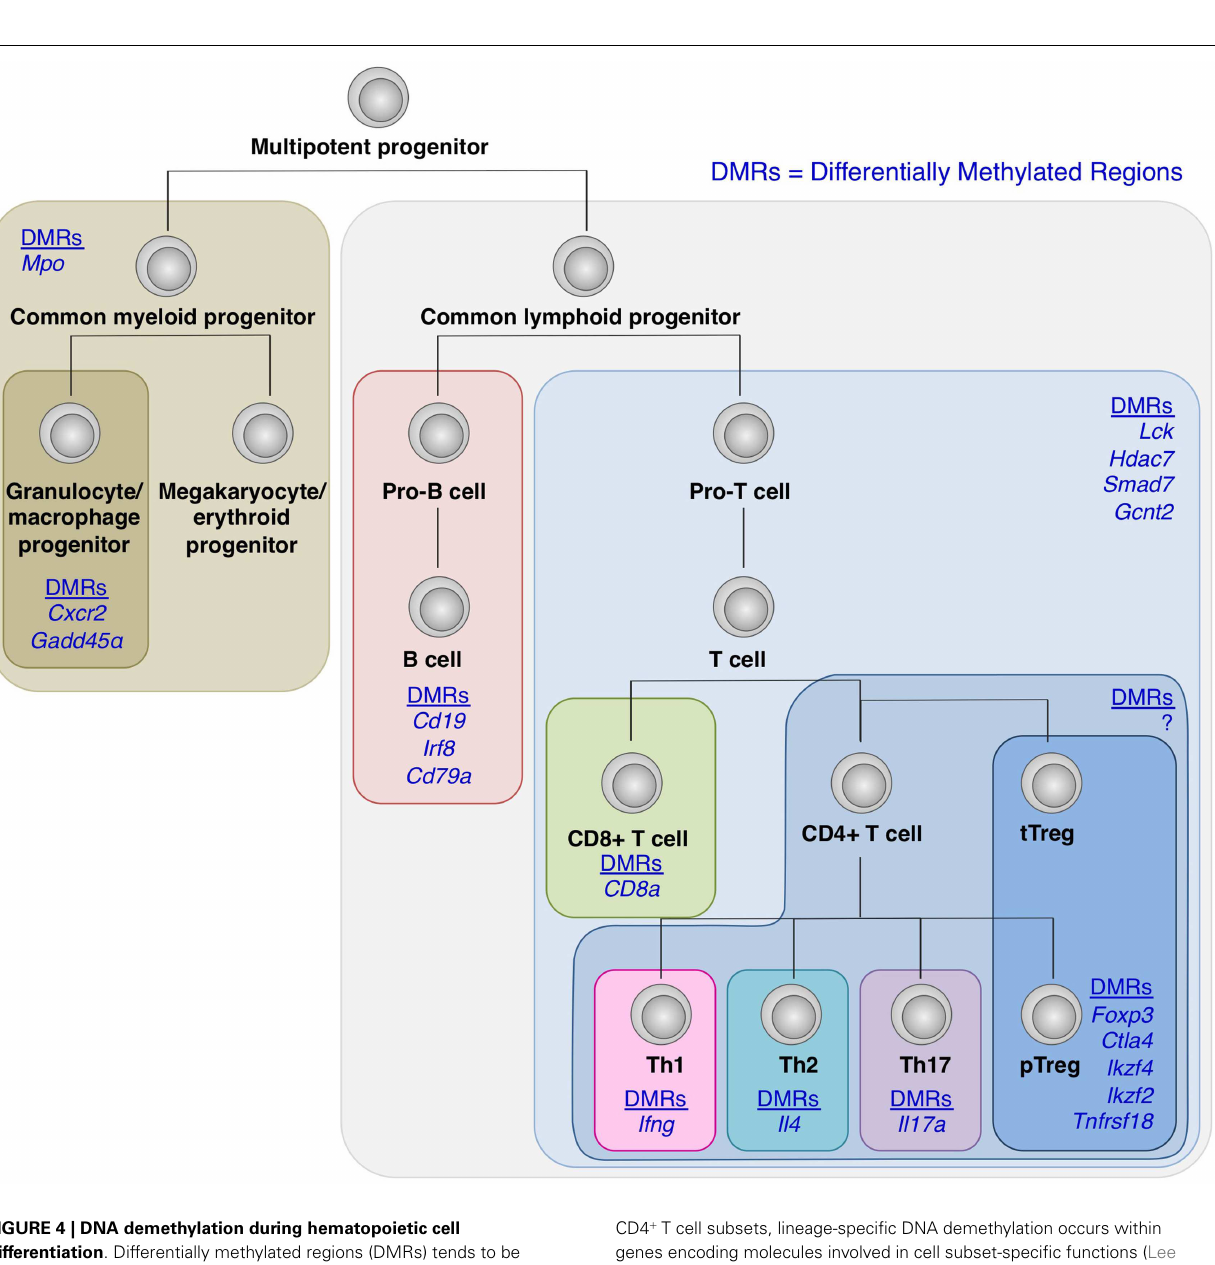
CD4 + T cell subsets, lineage-specific DNA demethylation occurs within genes encoding molecules involved in cell subset-specific functions (Lee et al., 2002; Ansel et al., 2003;Wilson et al., 2009; Cohen et al., 2011; Ohkura et al., 2012;Thomas et al., 2012).These findings suggest the involvement of epigenetic regulations during cell fate determination and linage